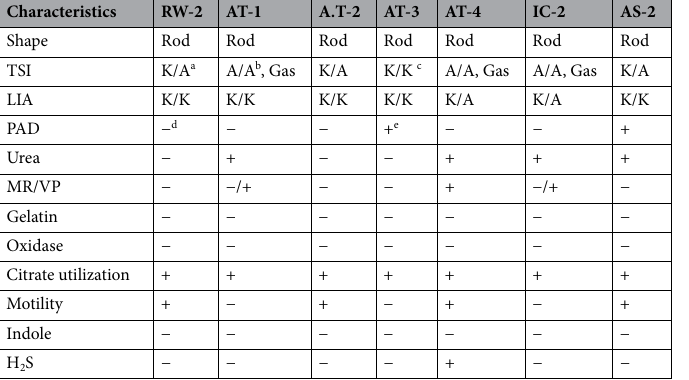
Table 5. Biochemical characterization of screened Gram-negative dominant bacterial community. a Alkaline over acid; b acid over acid; c alkaline over alkaline; d negative; e